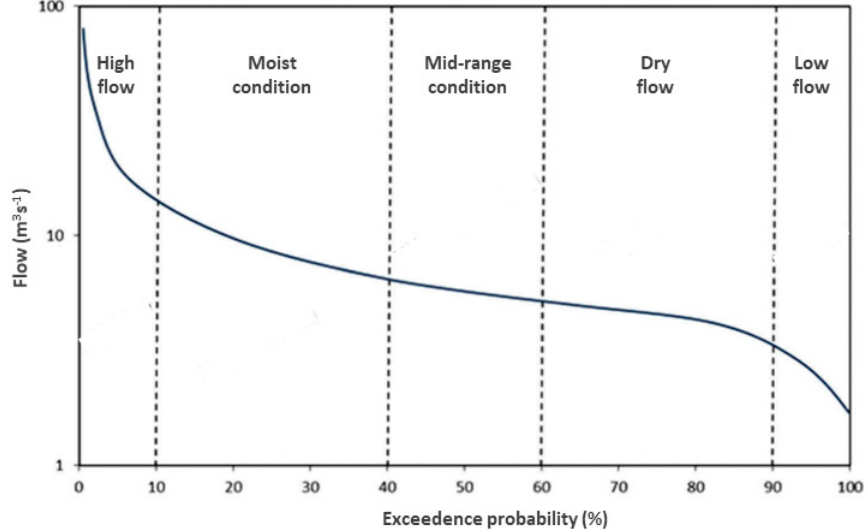
Figure 4. Division of the flow duration curve (adapted from Ranatunga et al. [7]).